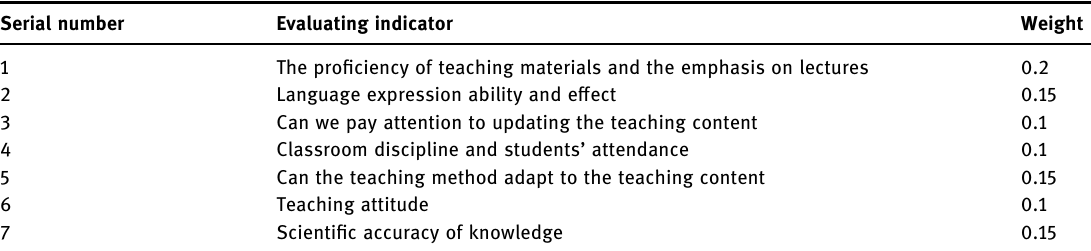
Table 6: Teacher evaluation index and weight coe ffi cient Serial